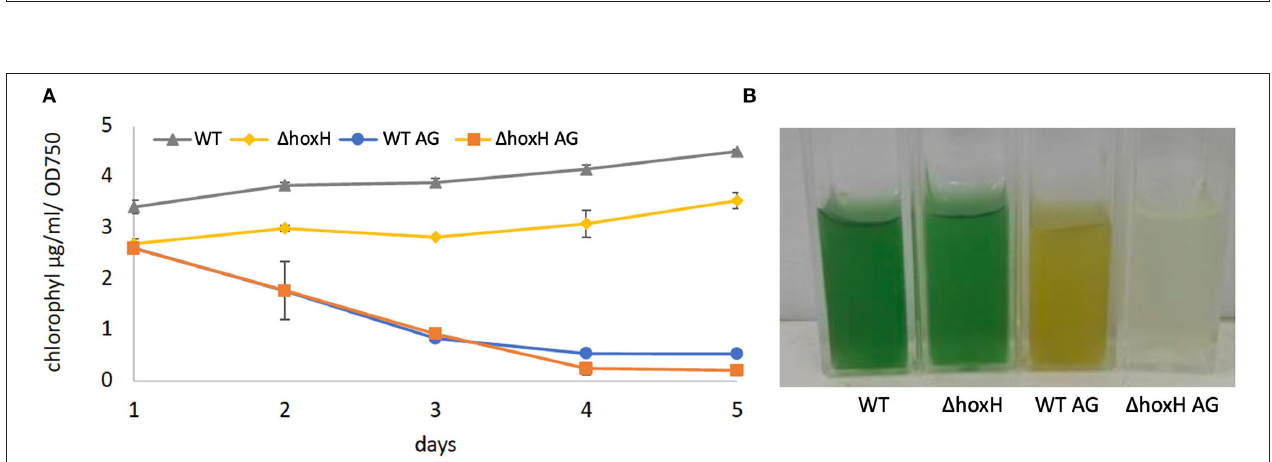
FIGURE 2 | (A) Chlorophyll content of WT and 1 hoxH during growth experiments under photoautotrophic conditions and on arginine and glucose. (B) The appearance of strains on day 3 after inoculation.